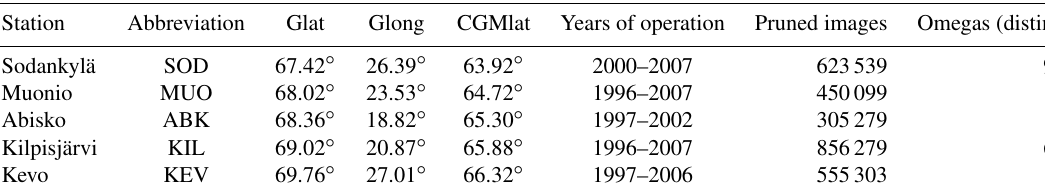
Table 1. Names, geographic coordinates, corrected geomagnetic latitudes, years of operation and the total number of pruned images for the Lapland ASC stations (from south to north) used in this study. The magnetic midnight in Fennoscandia meridian is at about 21:30UT.